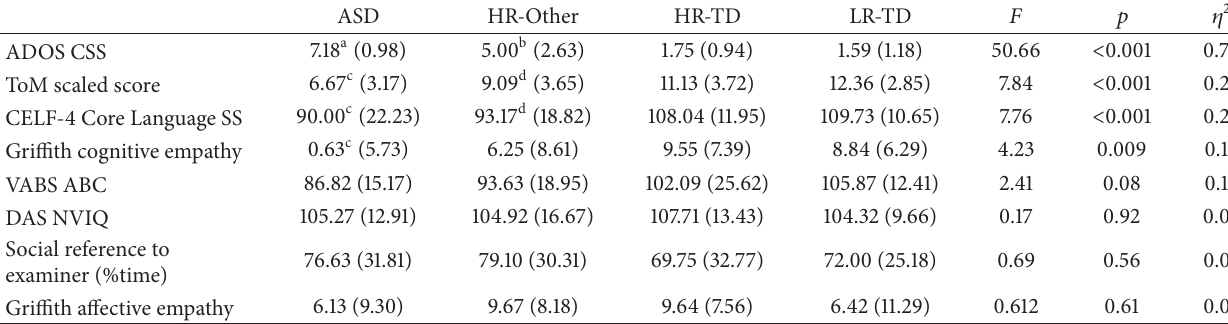
Table 2: Descriptive statistics by